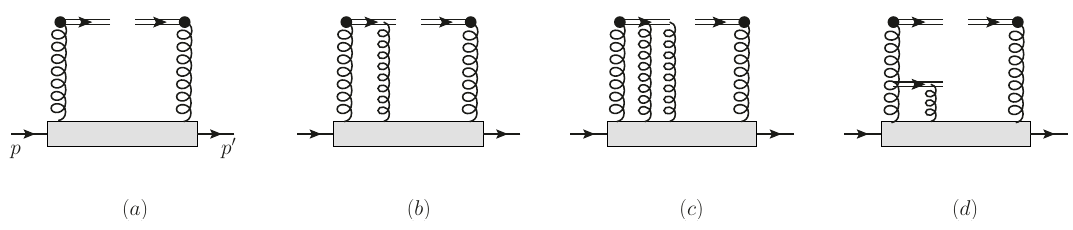
Figure 1 . The tree-level diagrams for quasi gluon GPDs. The double lines at the top of diagrams stand for gauge links along the z -direction. In (d) the double line in the middle is for the gauge link along the light-cone n